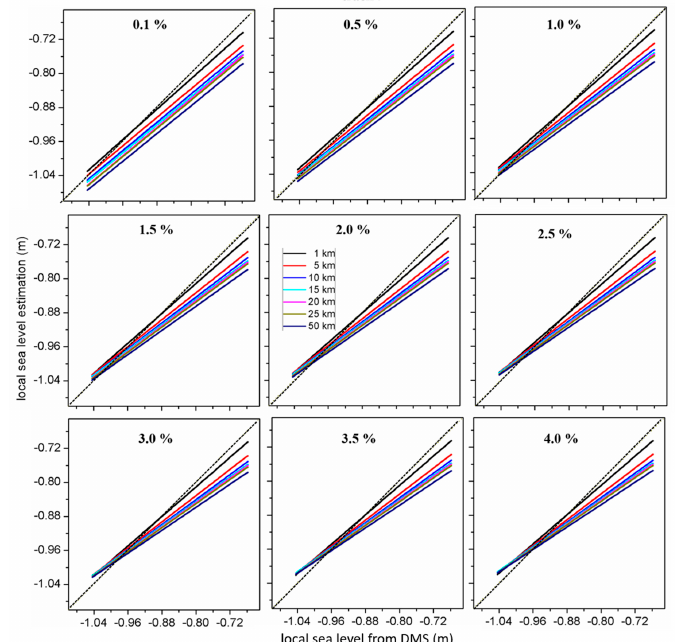
Figure 5. Linear fit lines of track 3 between retrievals from the lowest elevation method and those from the DMS method (ground truth) at 7 segment length scales: 1, 5, 10, 15, 20, 25, and 50 km, and 9 percentage scales: 0.1%, 0.5%, 1%, 1.5%, 2%, 2.5%, 3%, 3.5%, and 4%. The dashed line is the 1:1 line. All linear least square fits are statistically significant with greater than 95% confidence using an F